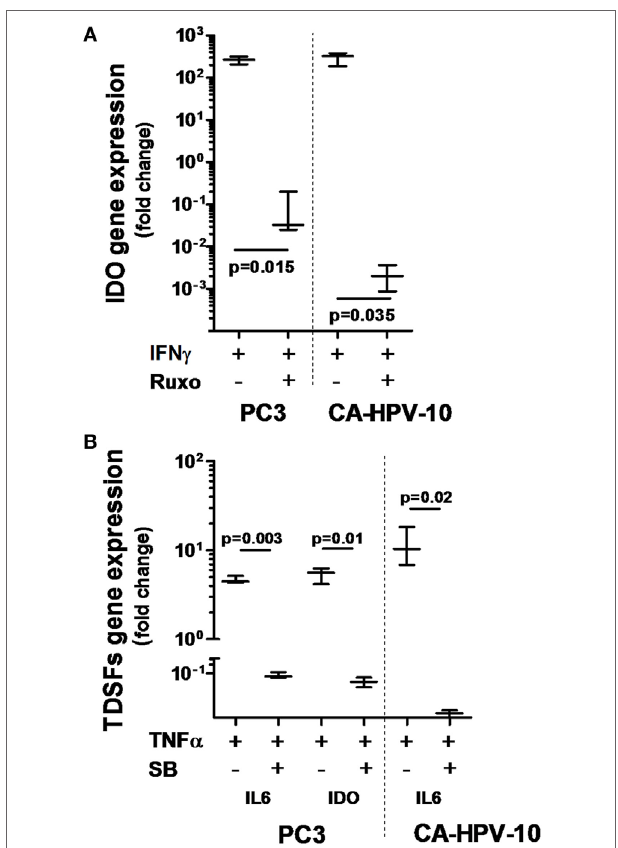
FigUre 4 | Interferon gamma receptor 1, 2 and tumor necrosis factor receptor 1 involvement in IFN- γ - and TNF- α -dependent indoleamine 2,3-dioxygenase (IDO) and interleukin (IL)-6 production. (a) IDO gene expression upon IFN- γ stimulation was significantly reduced by inhibition of the JAK-STAT signaling pathway with ruxolitinib in both cell lines tested (about 4-log less in PC3 and 5-log less in CA-HPV-10 cell lines). (B) The expression of IL-6 and IDO genes upon TNF- α stimulation was significantly reduced by inhibition of the p38MAPK kinase signaling pathway with SB202190 in both cell lines (Mann–Whitney U test). Experiments were conducted in triplicate and data are shown as box and whisker plot with SDs.